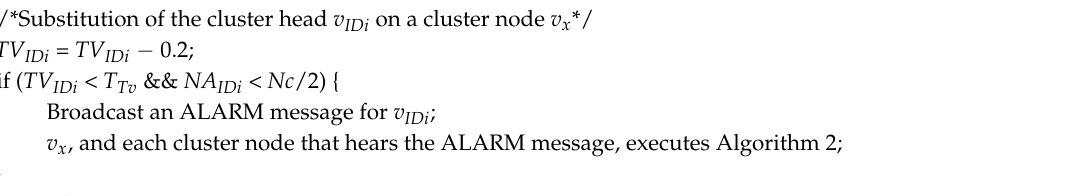
Algorithm 3. Substitution of Cluster